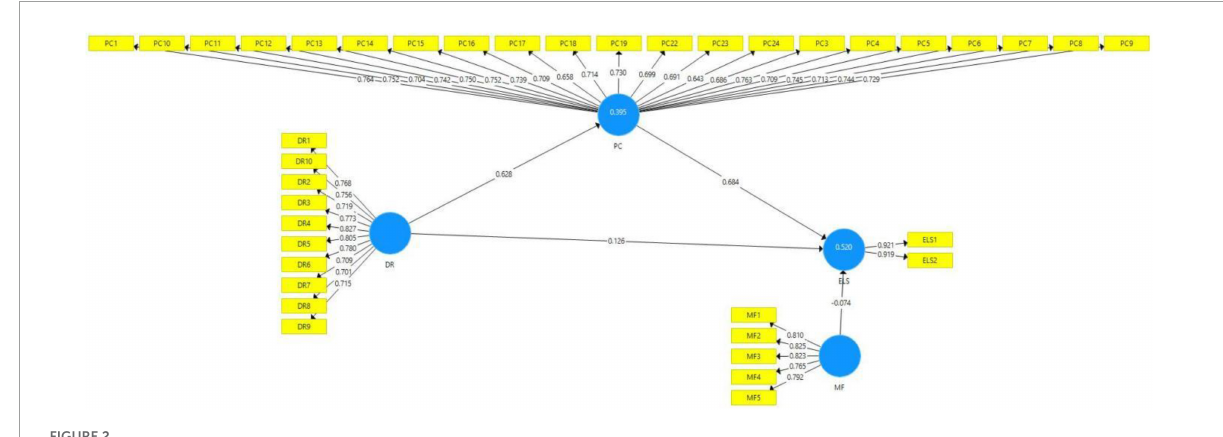
FIGURE2 Path estimates and outer